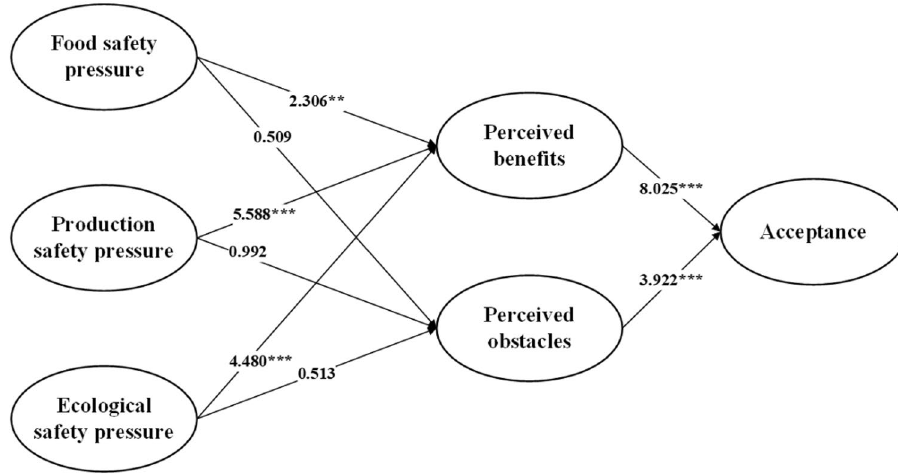
Figure 3. Results diagram. Note: *** p < 0. 001, ** p < 0. 01, * p < 0. 05. Data sources: Calculation and arrangement of this paper.